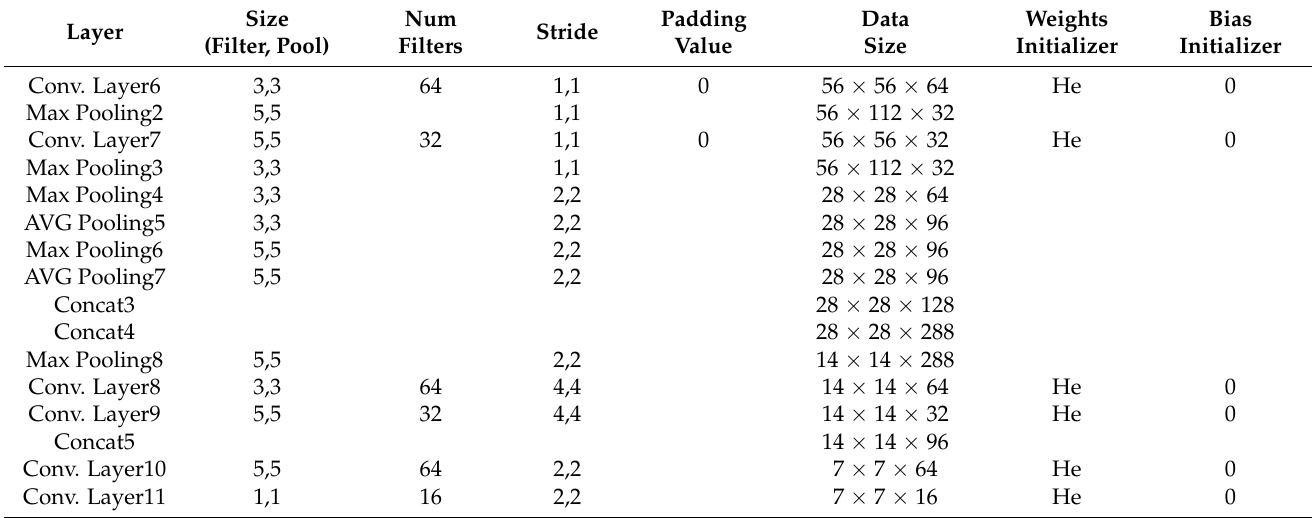
Figure 10. Proposed structure of Convolutional Layer3. Table 2. Layer Parameters in Figure